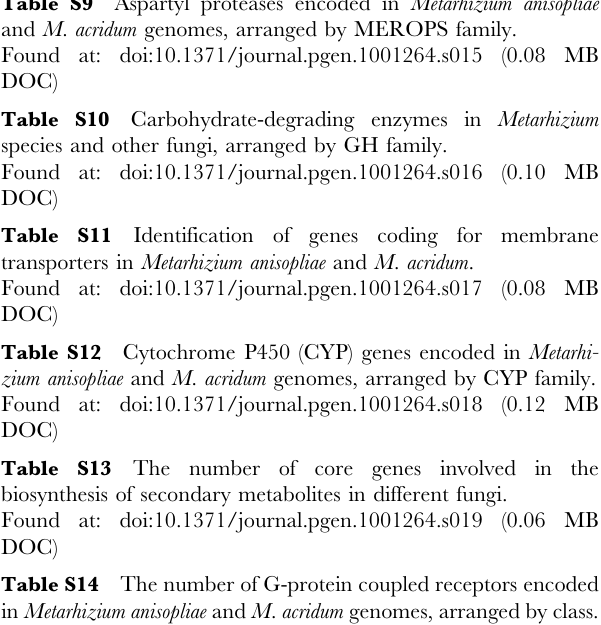
Table S14 The number of G-protein coupled receptors encoded in Metarhizium anisopliae and M. acridum genomes, arranged by class.